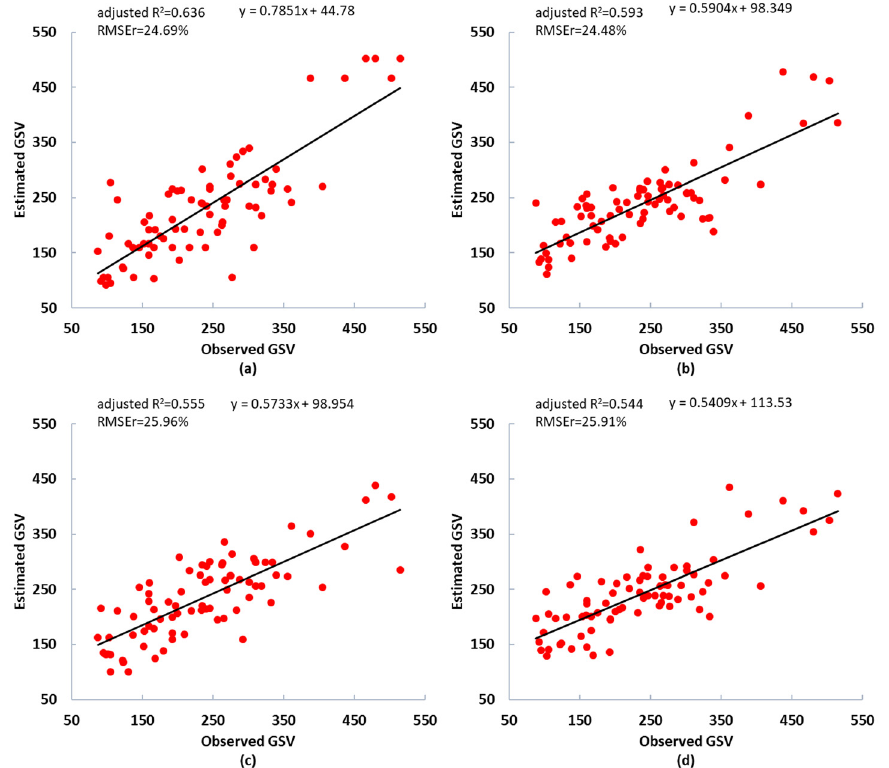
Figure 7. Scatter plots of the observed and estimated GSV values (m 3 /ha) using the GF-2 and Sentinel-2 image datasets with feature variables selected by the AFCO method. ( a , b ) GSV estimated from the GF-2 image using the KNN and RFR models, respectively. ( c , d ) GSV estimated from the Sentinel-2 image using the KNN and RFR models, respectively. The black line is the fitting trend of the estimated results.